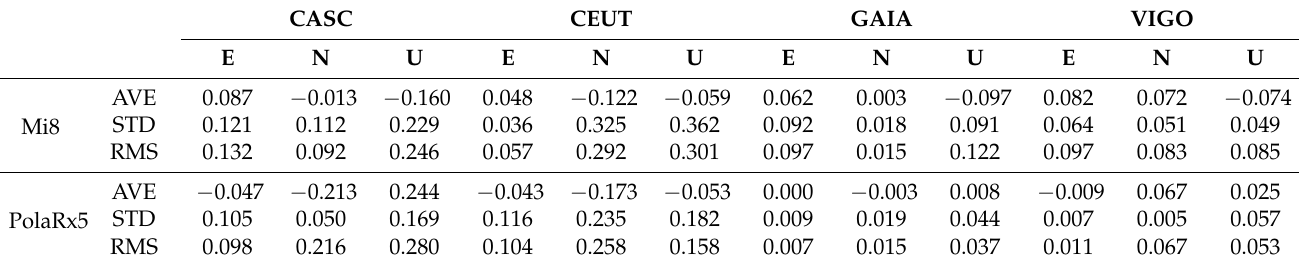
Table 11. Smartphone and receiver statistics at Test 3.